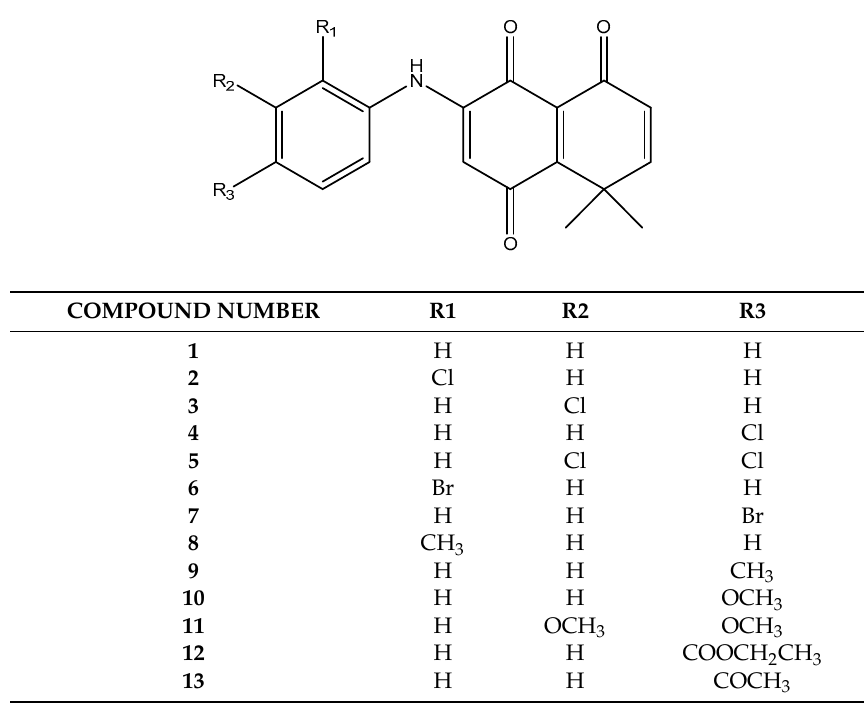
Figure 1. Derivatives of 8,8-dimethyl-3-[( R -phenyl)amino]-1,4,5(8 H )-naphthalentrione used in this study. The different compounds were numbered 1 – 13 .